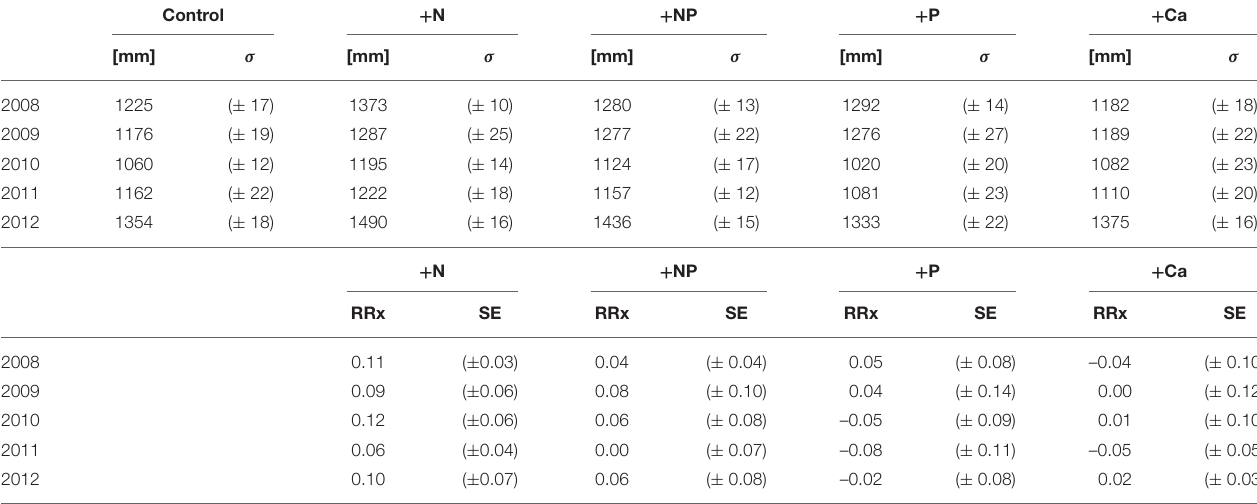
TABLE 1 | Throughfall fluxes between 2008 and